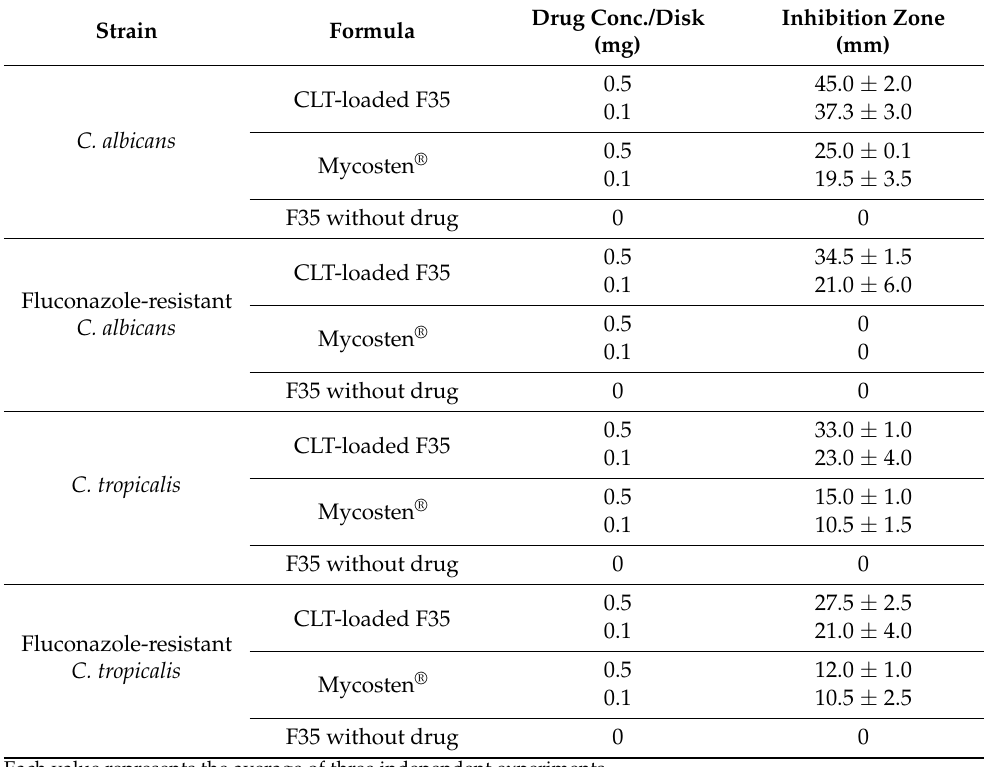
Table 3. Inhibition zone of wild-type and drug-resistant C. albicans as well as C. tropicalis treated with CLT-loaded F35 and commercial cream, Mycosten ® .